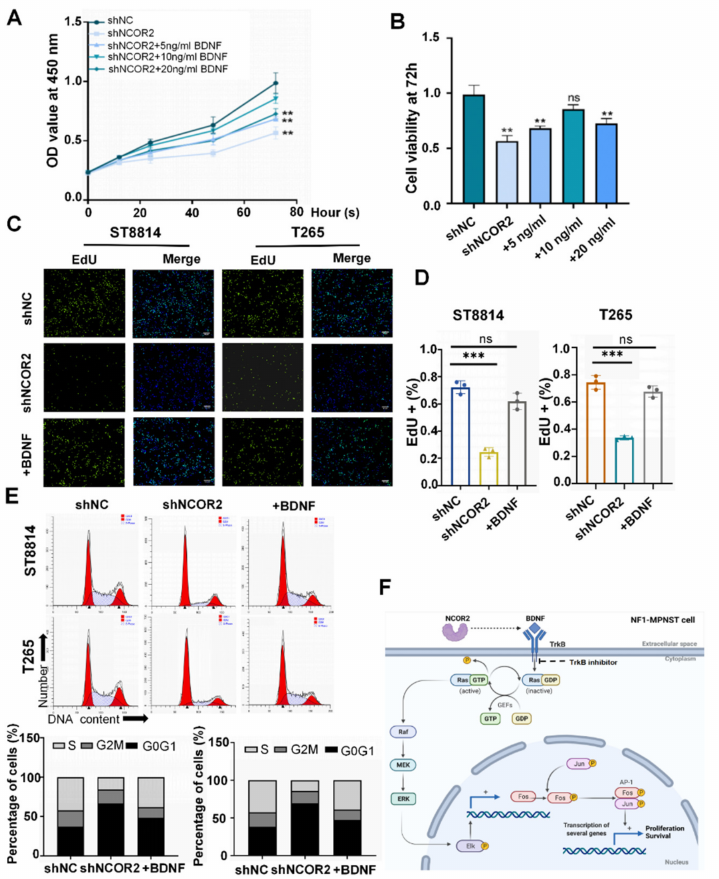
Figure 6. Human recombinant BDNF can reverse the effects of NCOR2 knockdown on NF1-derived MPNST cells. ( A , B ) CCK-8 assays showing the growth of all T265-shNCOR2 groups was promoted, and the effect with 10 ng/mL human recombinant BDNF was the most obvious, ** p < 0.05. ( C , D ) EdU assays showing that ST8814-shNCOR2 and T265-shNCOR2 cells with 10 ng/mL human recombinant BDNF had a higher growth rate than those without BDNF. Data are shown as mean ± S.D., n = 3; ns, not significant; *** p < 0.0005. ( E ) The cell cycle assays showing the proportion of proliferative cells increased evidently after ST8814-shNCOR2 and T265-shNCOR cells treated with human recombinant BDNF. ( F ) The BDNF protein in NF1-derived MPNST cells plays a key role in NCOR2-mediated MAPK